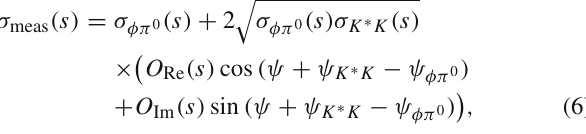
The functions σ K ∗ K ( s ) and ψ K ∗ K ( s ) are determined